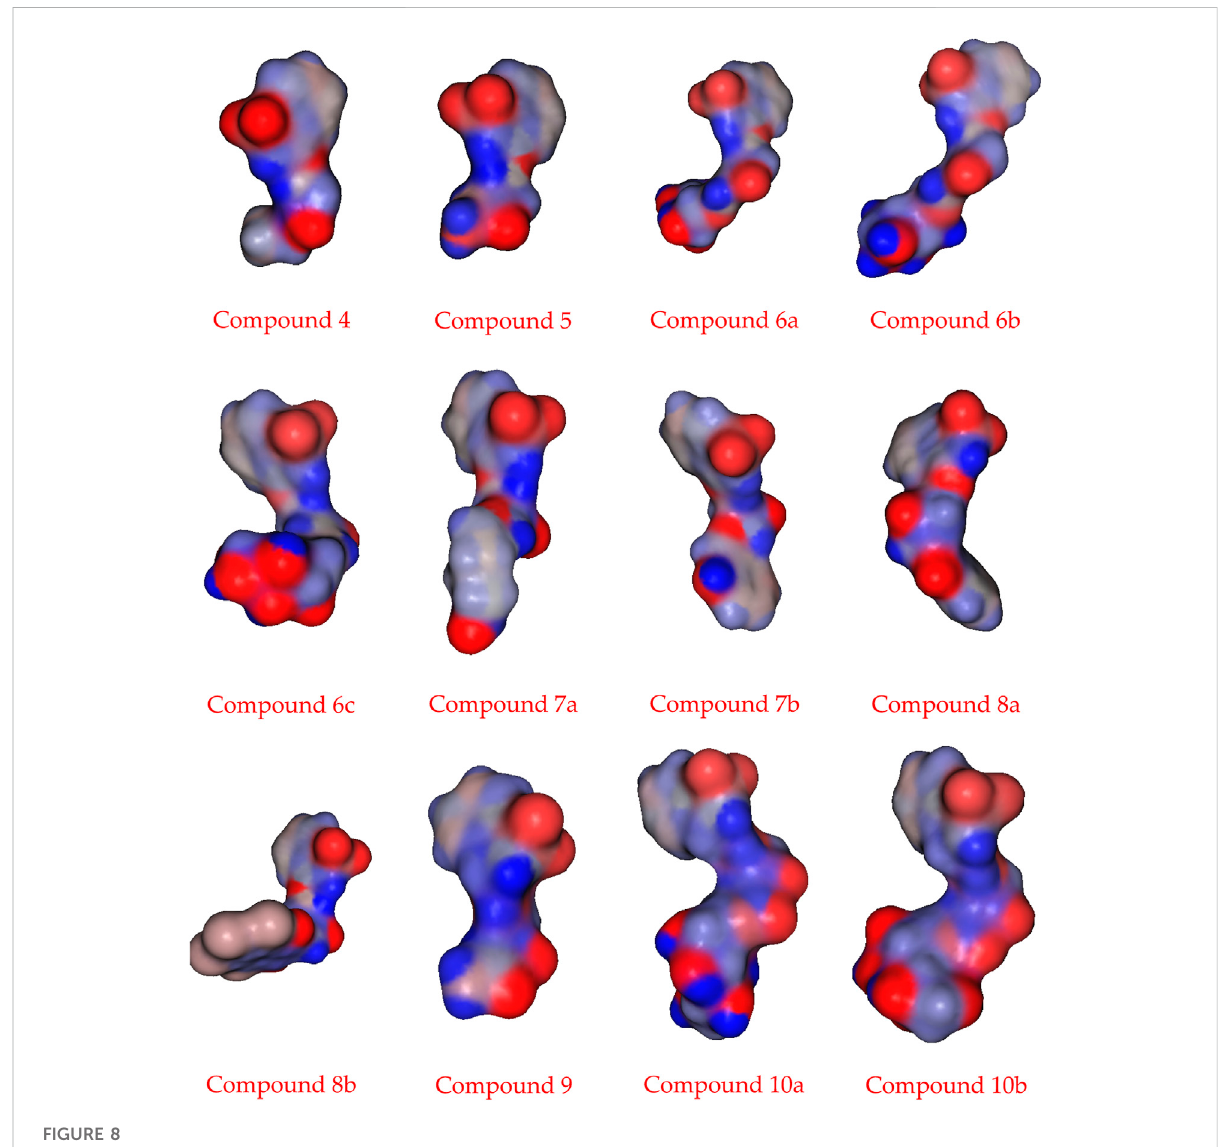
FIGURE 8 Geometric form of